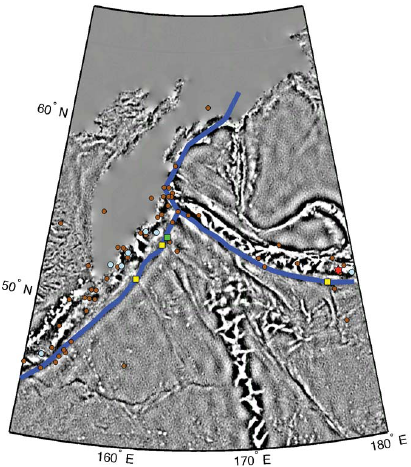
Fig. B4. Tectonic setting and key data for the Aleutian and Kam- chatka regions. See Fig. B1 for legend.